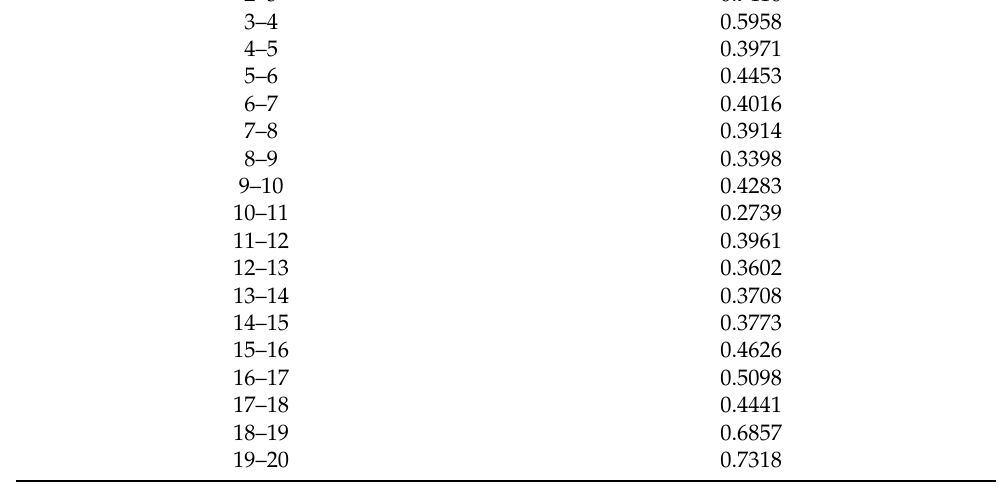
Figure 4. The normalized array factor for 2- element array antenna (a) using uniform distribution and (b) using FKE optimization.